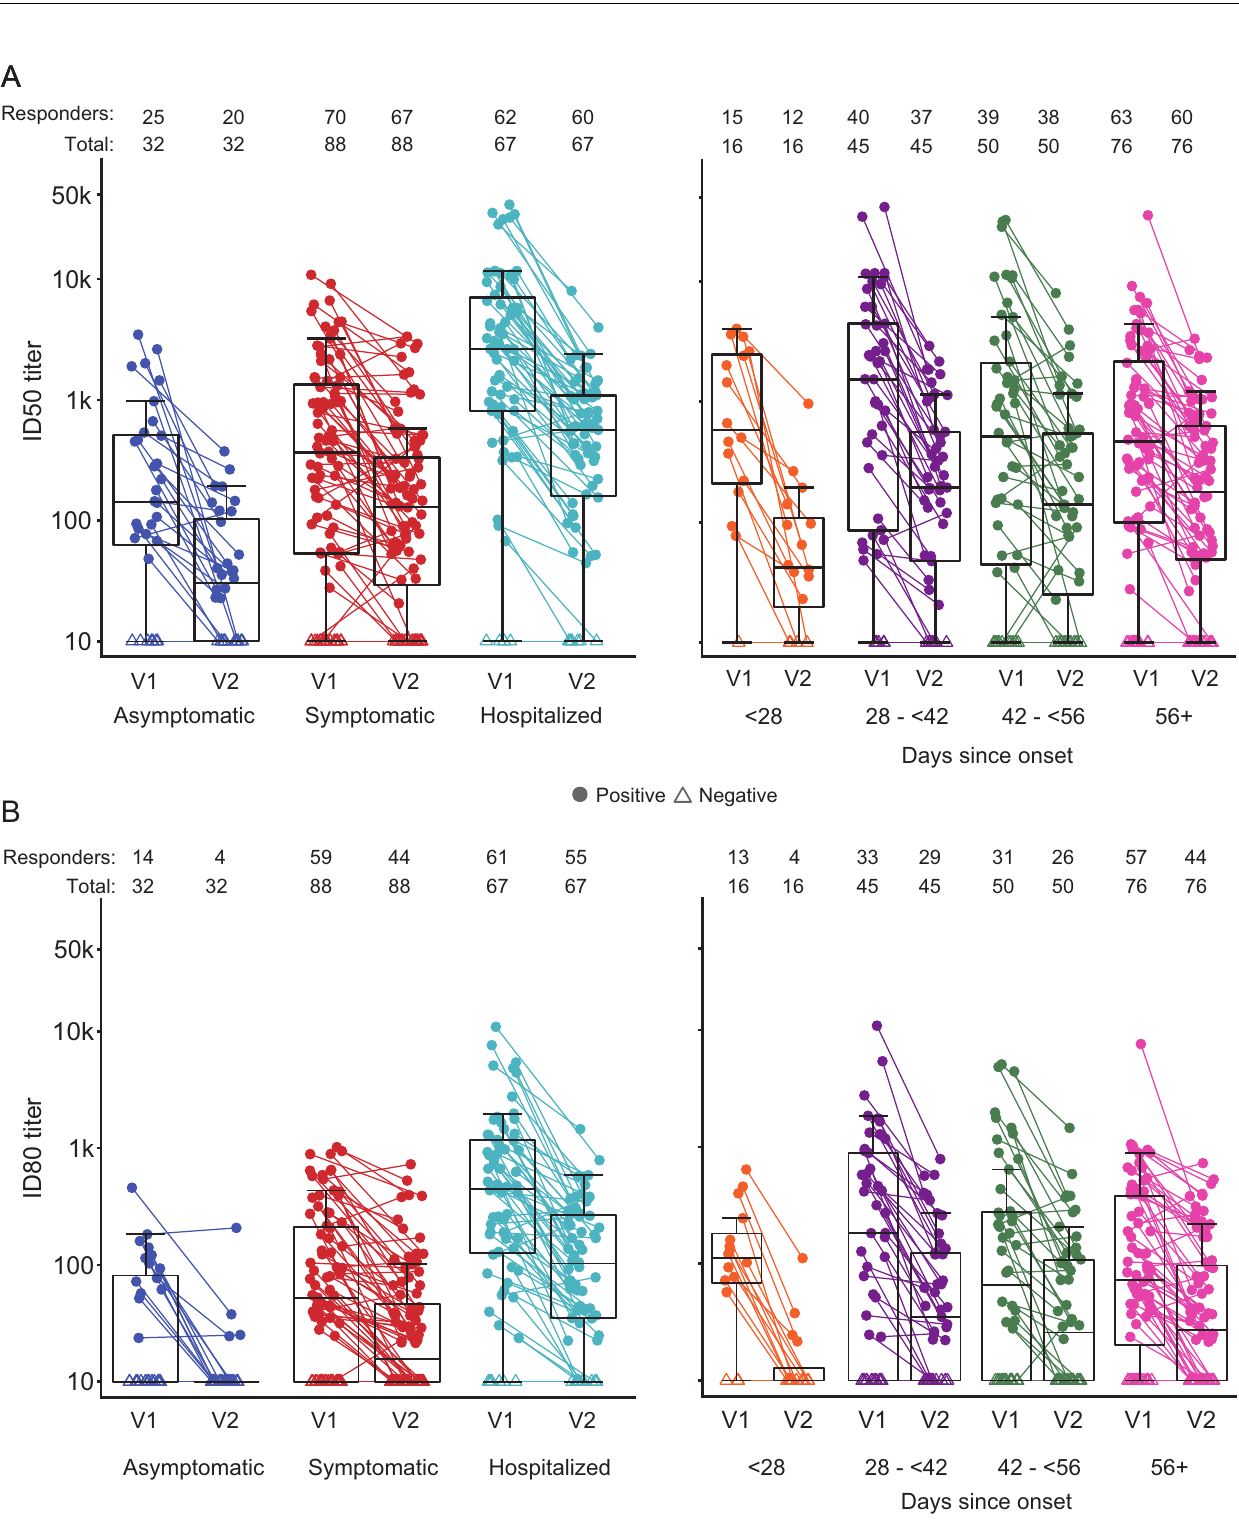
Fig 2. nAb response titers (ID50/ID80) at V1 (enrollment visit) and V2 (2 months after V1) by COVID-19 severity and days since SARS-CoV-2 diagnosis at V1 among participants ( n = 186) with data at both time points. Gray lines connect the nAb titer at V1 and V2 within participants. A. ID50. B. ID80. COVID-19, Coronavirus Disease 2019; nAb, neutralizing antibody; SARS-CoV-2, Severe Acute Respiratory Syndrome Coronavirus